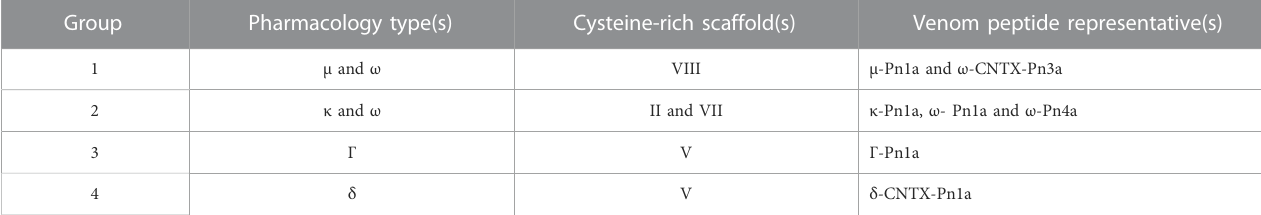
TABLE 1 Pharmacological groups identi fi ed in this study with respective pharmacological types, cysteine-rich scaffold types, and representative venom peptides described in the literature. Unexplored peptides within each group are described in Figure 5 and/or Supplementary Table S1.